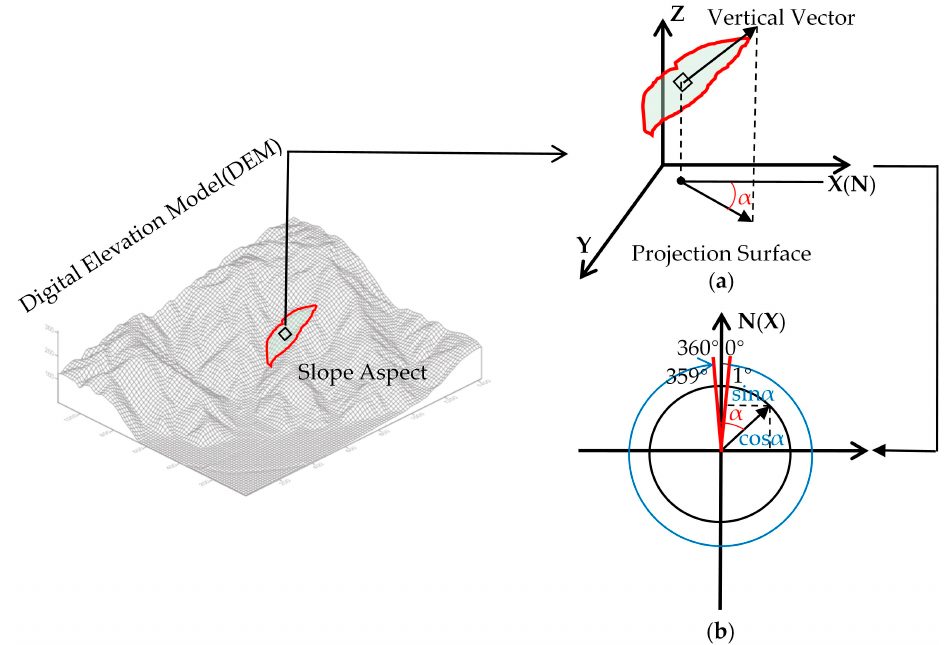
Figure 2. Schematic definition of aspect. ( a ) The definition of slope aspect; ( b ) the calculated slope aspect is the azimuth value ranging from 0 to 360 degrees, with the true north direction of 0